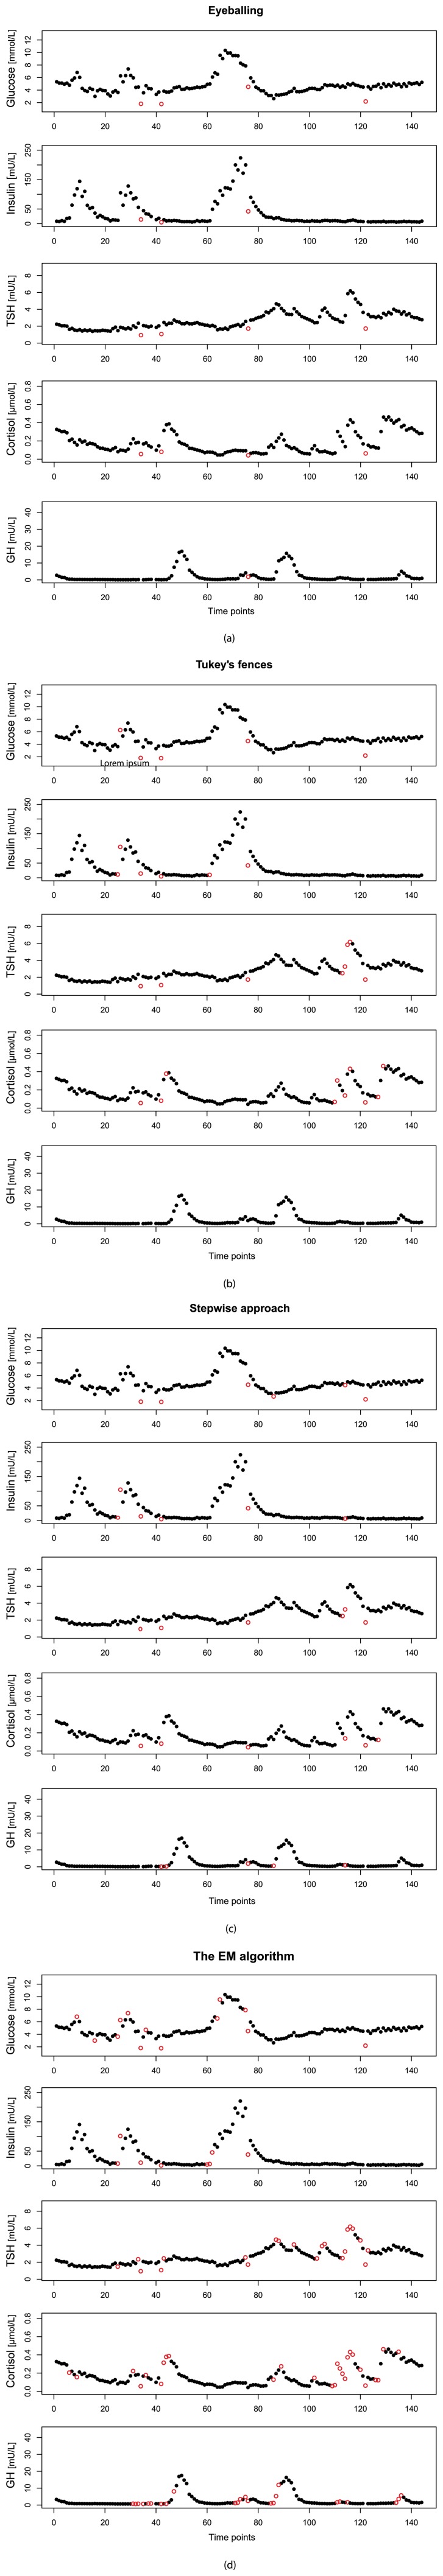
(a) The results of outlier detection by eyeballing in glucose, insulin, thyroid-stimulating hormone (TSH), cortisol, and growth hormone of participant 19. Hollow data points indicate detected outliers (b) The results of outlier detection by Tukey’s fences Hollow data points indicate detected outliers (c) The results of outlier detection by stepwise approach Hollow data points indicate detected outliers Hollow data points indicate detected outliers (d) The results of outlier detection by the expectation-maximization algorithm. Hollow data points indicate the probability of the data point to be an outlier is higher than 0.9.